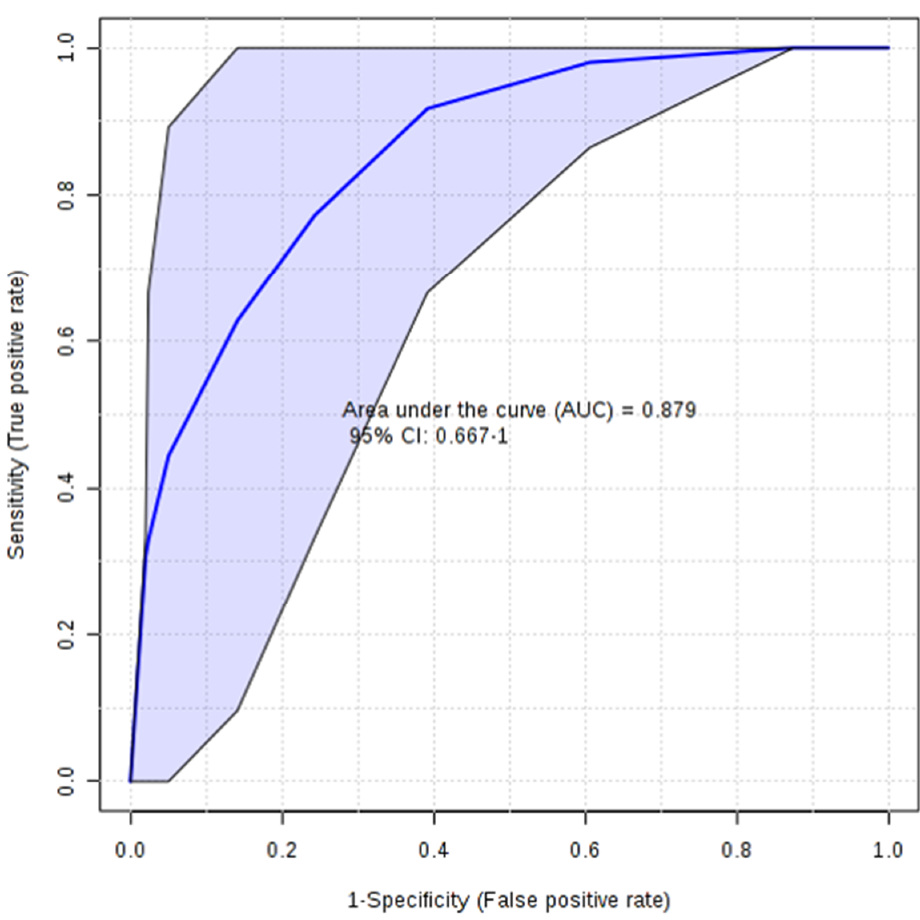
Figure 4. Box-and-whisker plots showing an altered expression of metabolites including acetoacetate, creatine, creatinine, histamine, phenylacetylglycine, and tryptophan between C and CRC patients. Median values are highlighted by solid lines. Statistical significance of the metabolites ( p ≤ 0.05) is presented in Table 2.